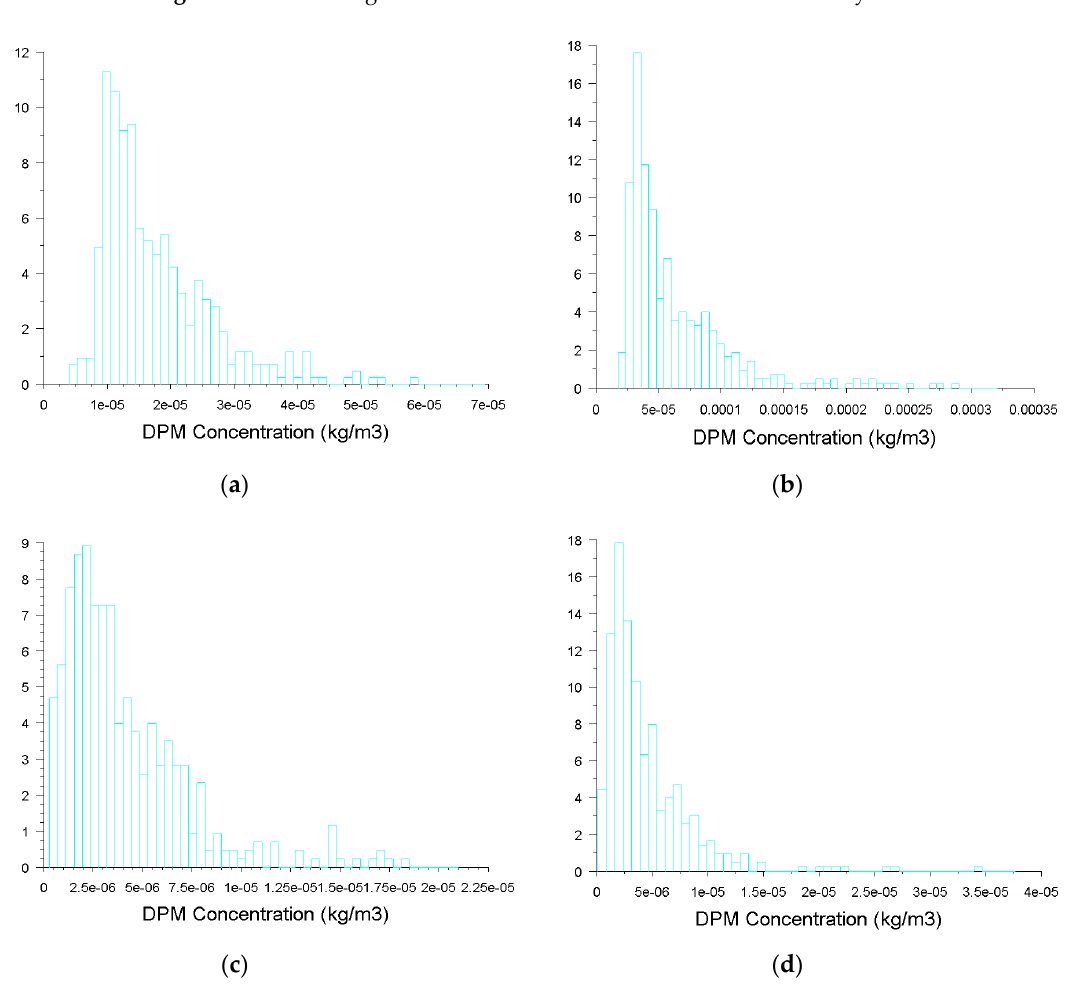
Figure 18. Dust concentration distribution histogram at the working face outlet: ( a ) total dust for long-short ventilation system; ( b ) respirable dust for long-short ventilation system; ( c ) total dust for vortex ventilation system; ( d ) respirable dust for vortex ventilation system.